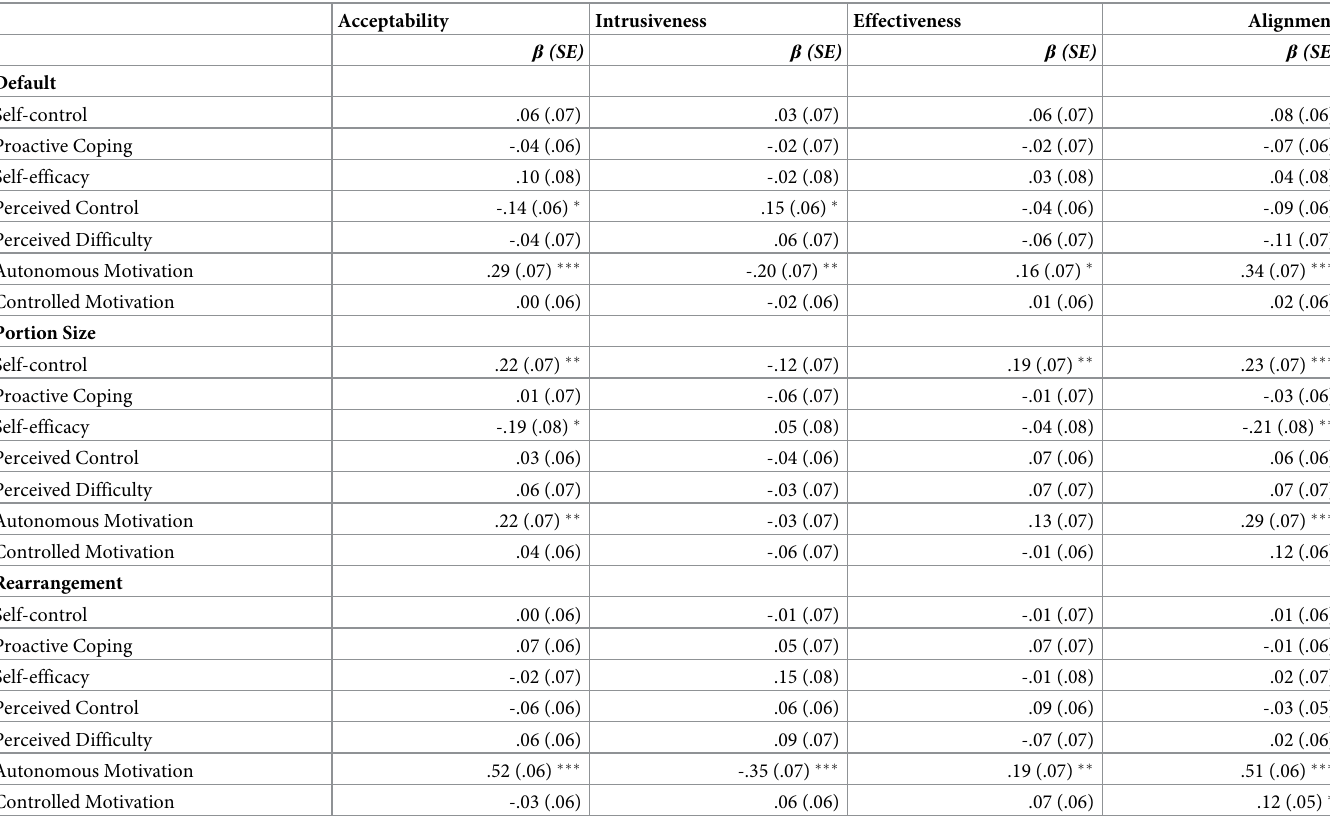
Table 5. Linear regression models predicting acceptability, intrusiveness, perceived effectiveness and goal alignment for the three different types of